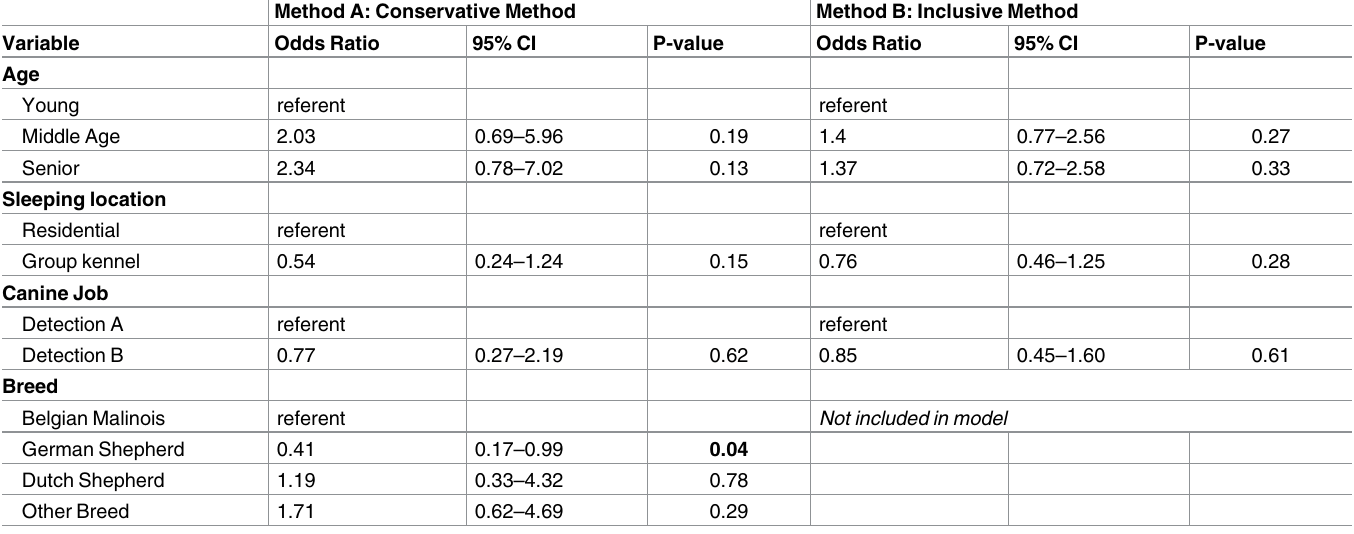
Table 2. Association between seropositive dogs (defined by method A and B) and age, breed, job and sleeping